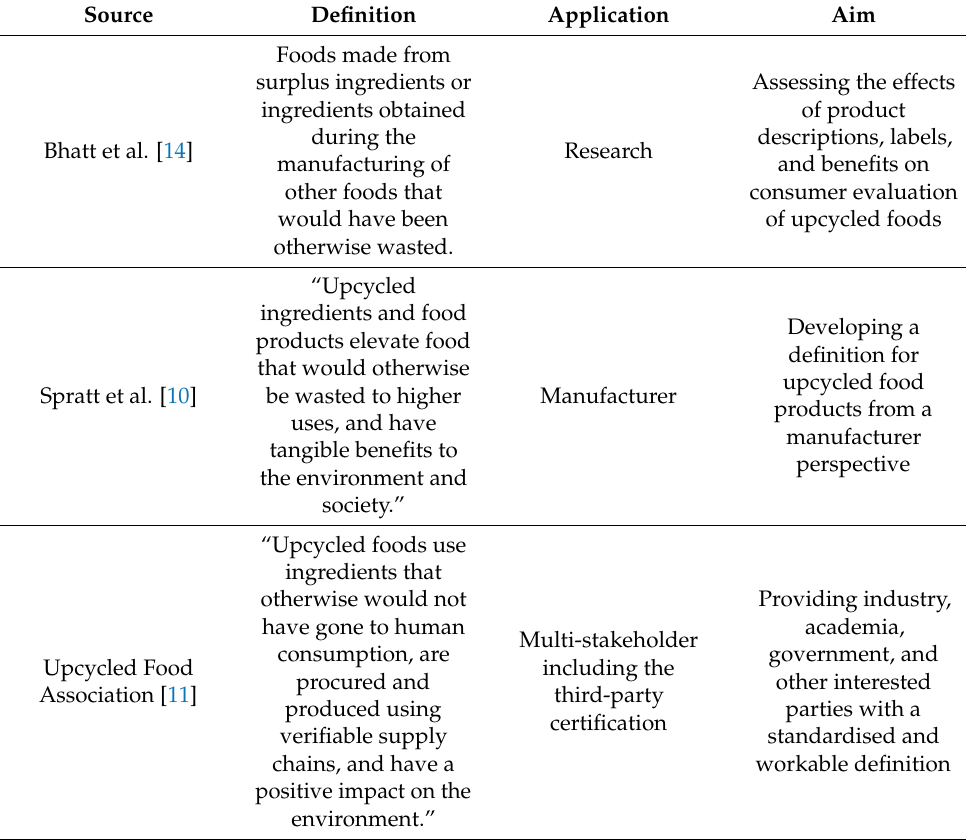
Table 1. Upcycled food